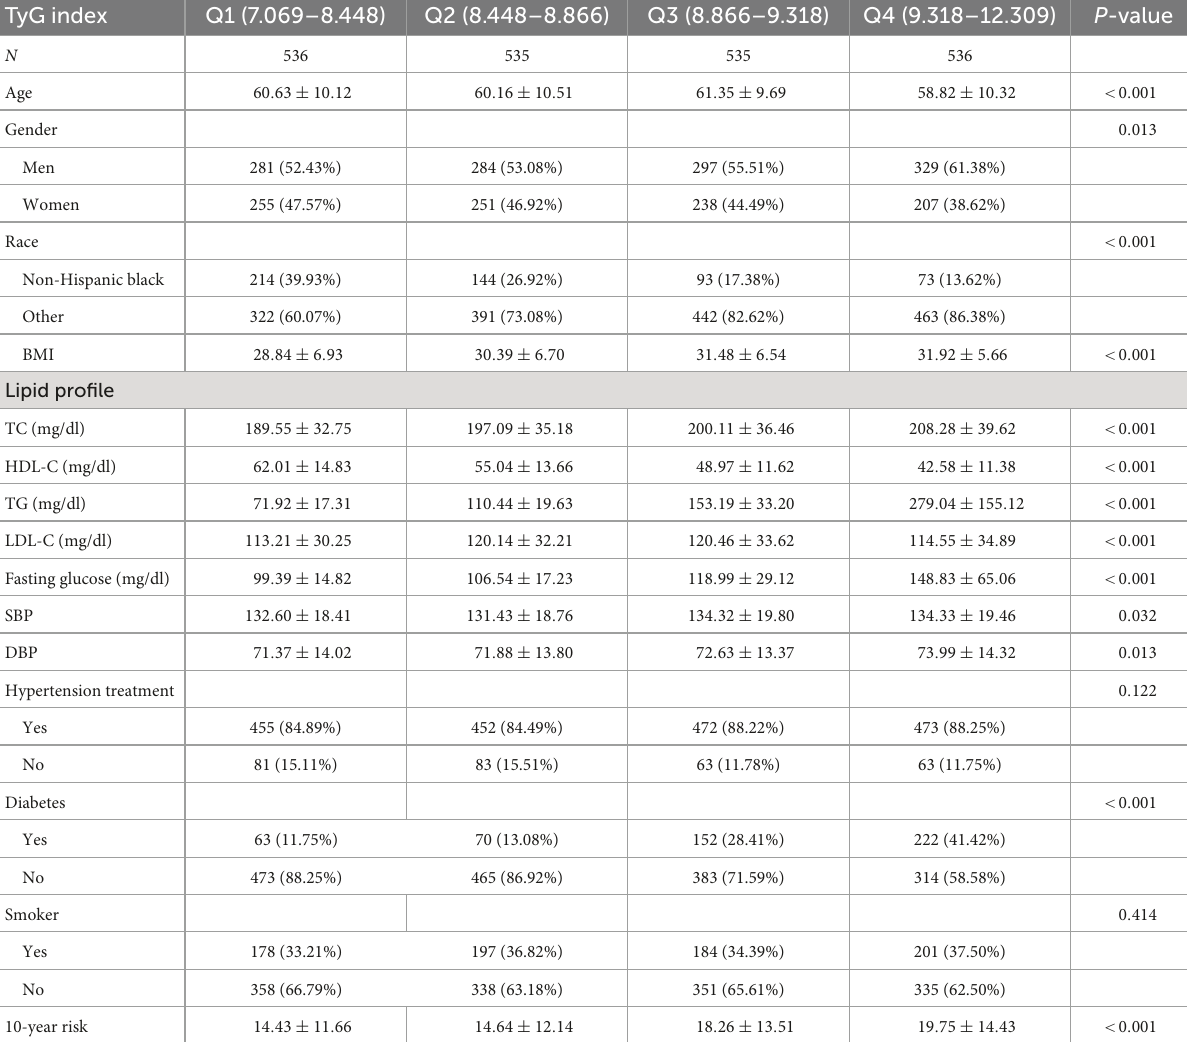
TABLE 1 Baseline characteristic of participants.